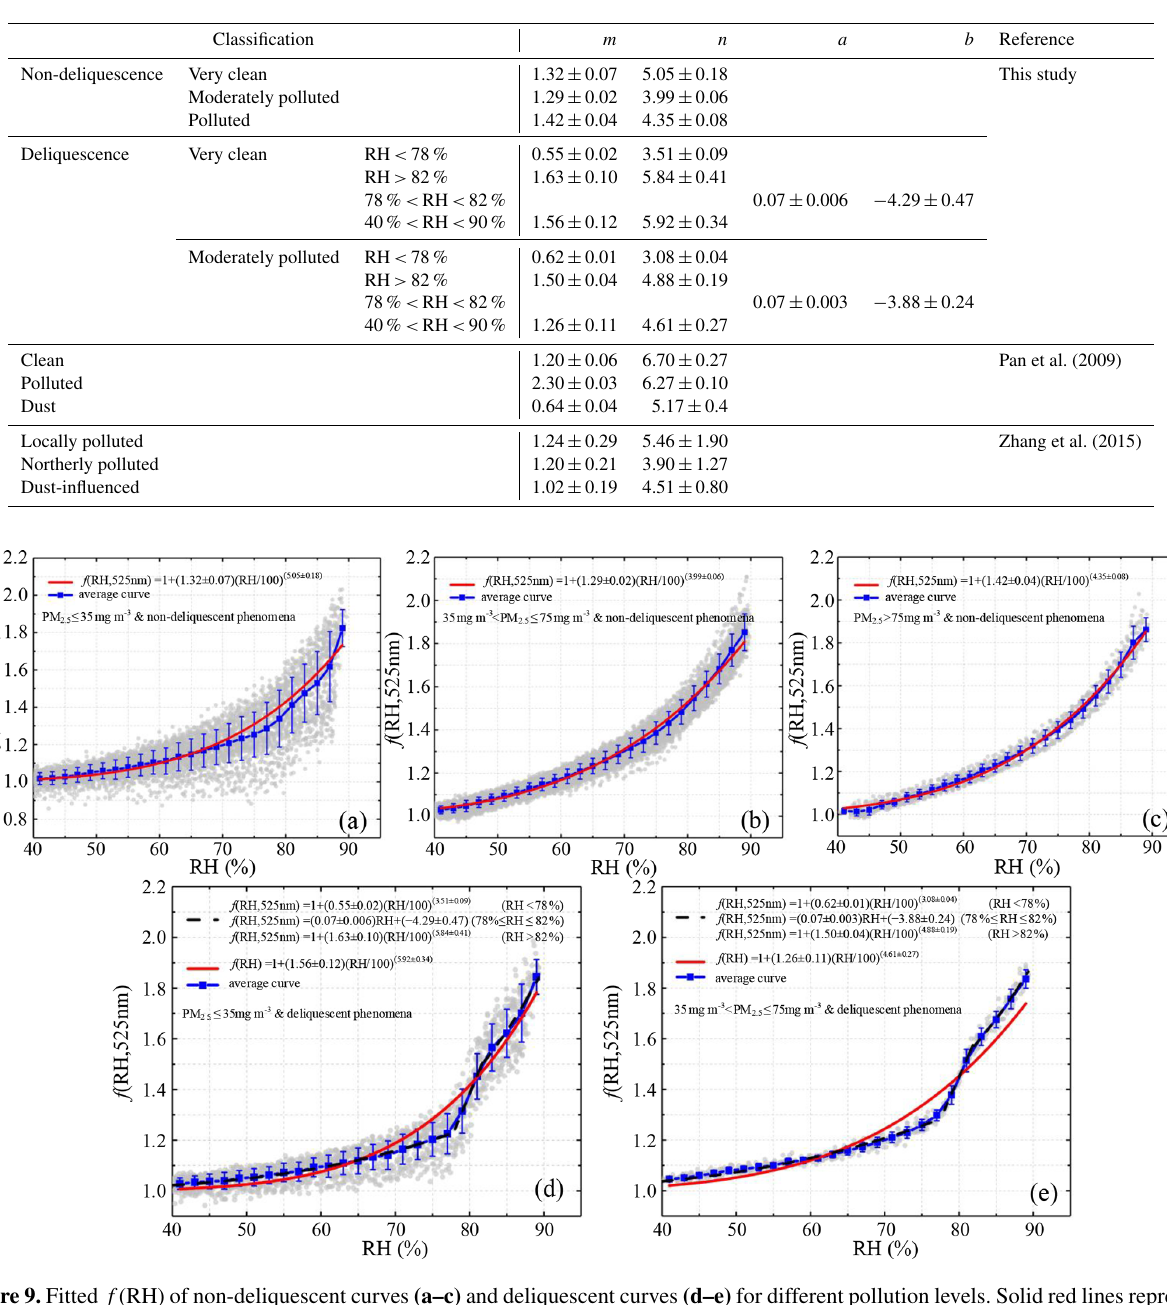
Table 2. Curve-fitting parameters of f (RH) at 525nm for different aerosol types using Eqs. (10) and (12). Classification